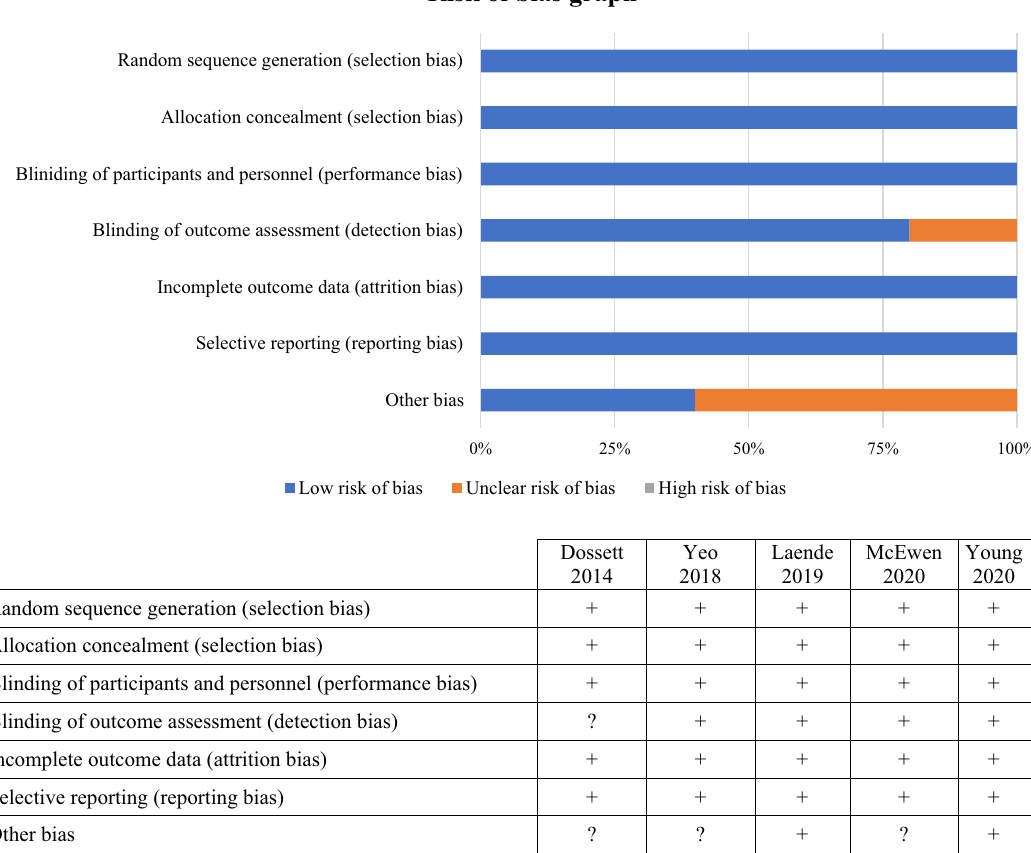
Table 2. Modi fi ed-Jadad score.